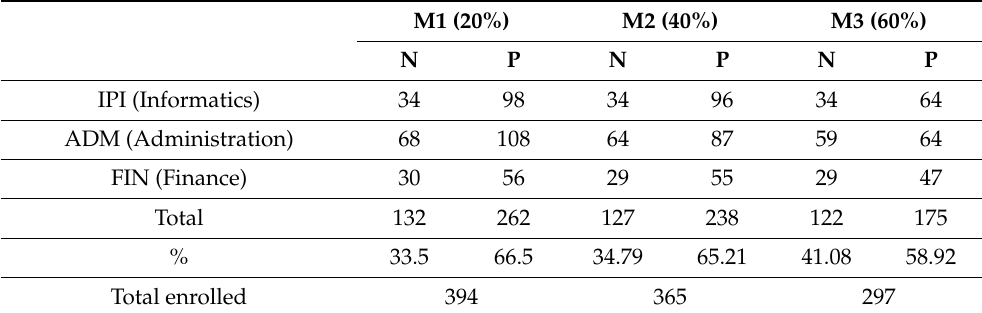
Table 2. Distribution of classes for each course and moments. Rows are related to the three courses and columns refer to the moment of collection (at 20%, 40%, and 60% of course completion). The positive class (P) refers to students who did not graduate after three years and the negative class (N) refers to students who did graduate. M1 (20%) M2 (40%) M3 (60%) N